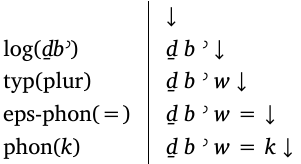
Figure 4: Computation for ḏbʾw=k